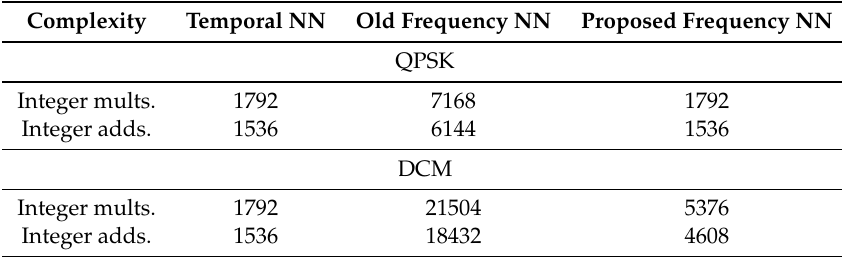
Table 2. Complexity summary for n = 128 subcarriers.